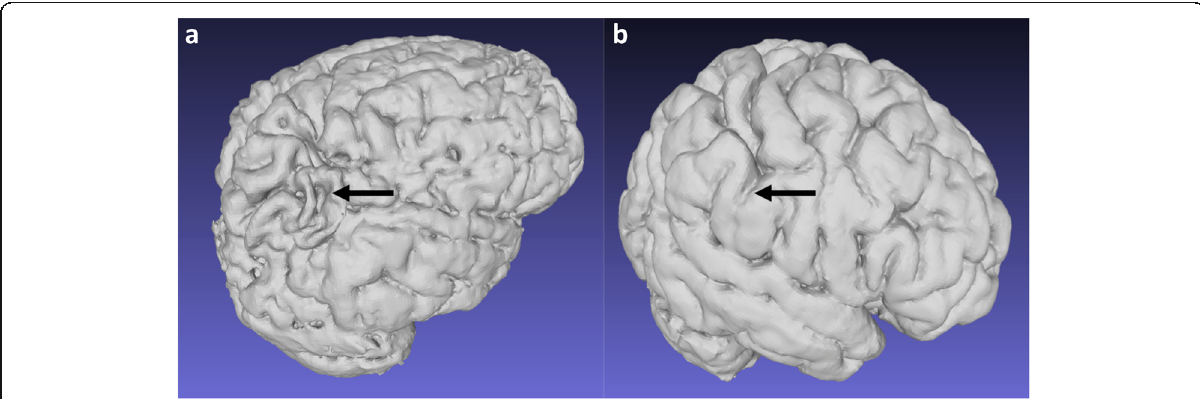
Fig. 5 a , b 3D reconstructions of the brain after skull stripping and segmentation of the cortex. Isolated peri-Sylvian involvement in a 10-year-old girl ( a ) compared with a normal 12-year-old girl ( b ) serving as a control. The volumes demonstrate isolated atrophy in the peri-Sylvian regions (black arrow) in the child with prior partial-prolonged HII ( a ) as compared to the normal thickness of the gyri (black arrow) in the control ( b